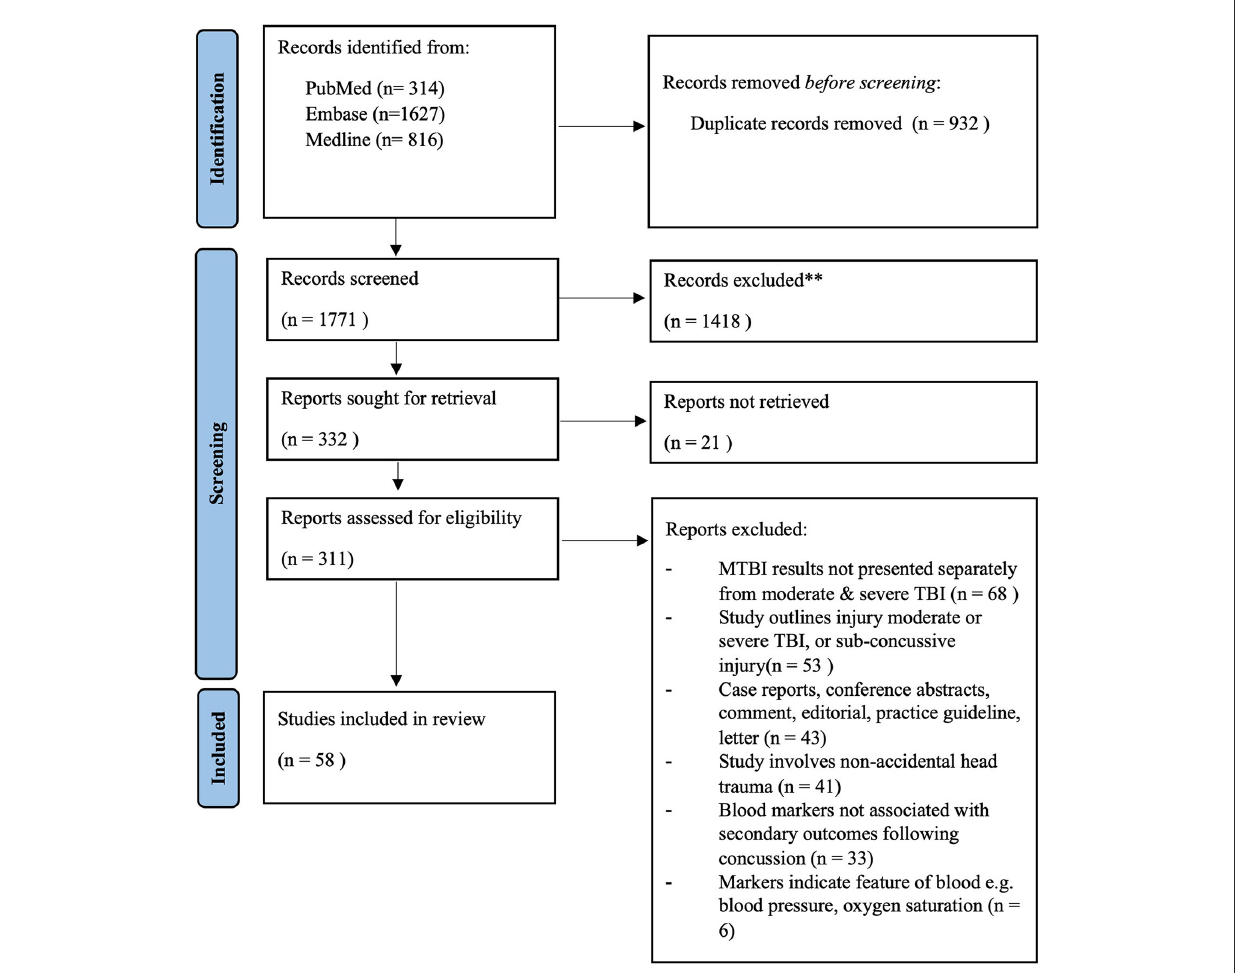
FIGURE1 Summary of study selection process following PRISMA